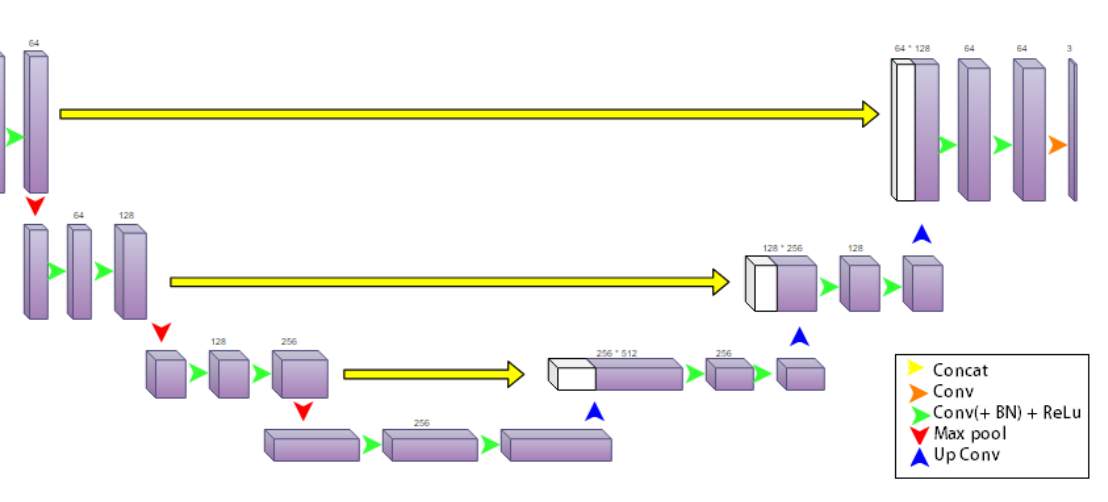
Figure 13. 3D U-Net